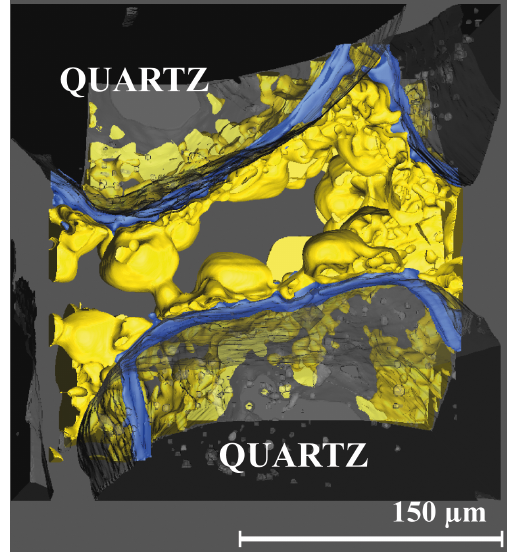
Figure 11. Volume-rendered image of the water film (blue) in be- tween hydrate (yellow) and the quartz grains – for better under- standing the outer surface of the grains – is depicted at α -scale transparency. Voxel resolution for this scan was